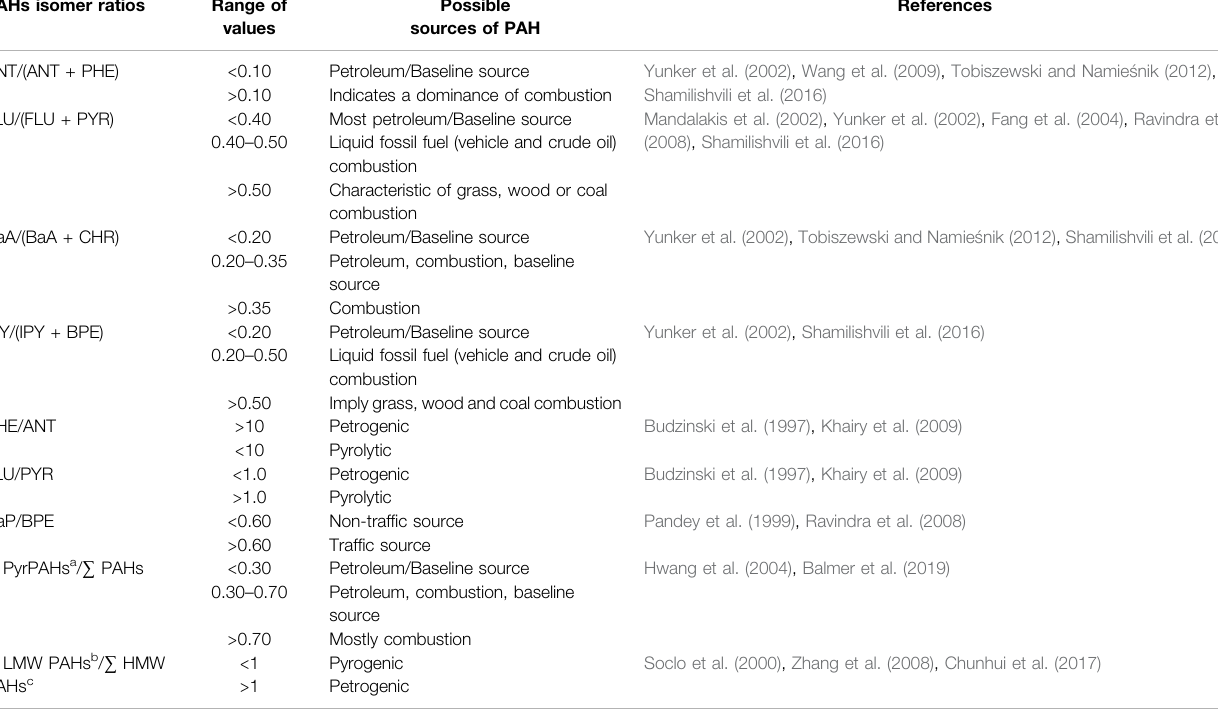
TABLE 3 | Possible PAHs isomer ratios. PAHs isomer ratios Range of